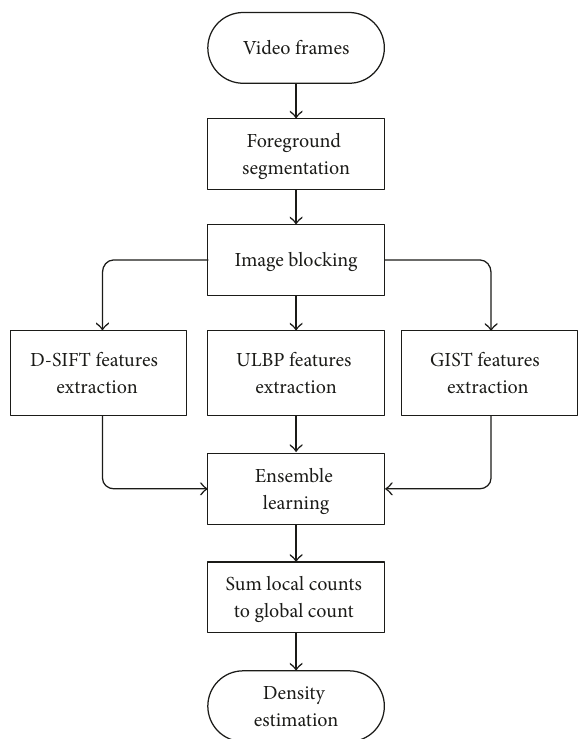
Figure 1: Flow chart of the